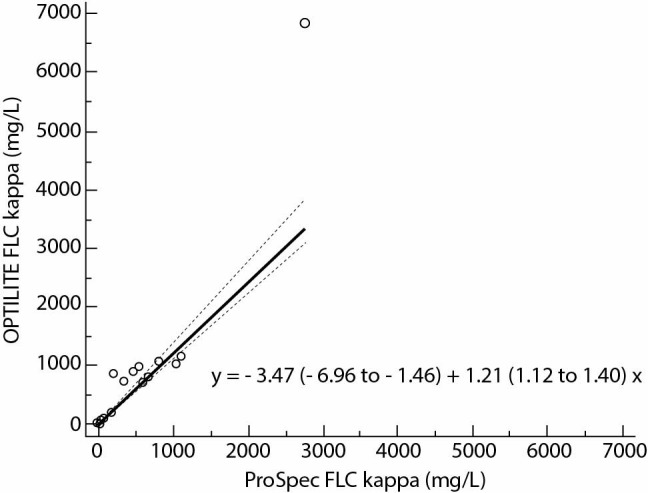
Method comparison results with 95% confidence interval (N = 37) of FLC kappa assays on ProSpec and Optilite analysers. The regression equation indicates the existence of constant and proportional error (P = 0.740). FLC - free light chain.